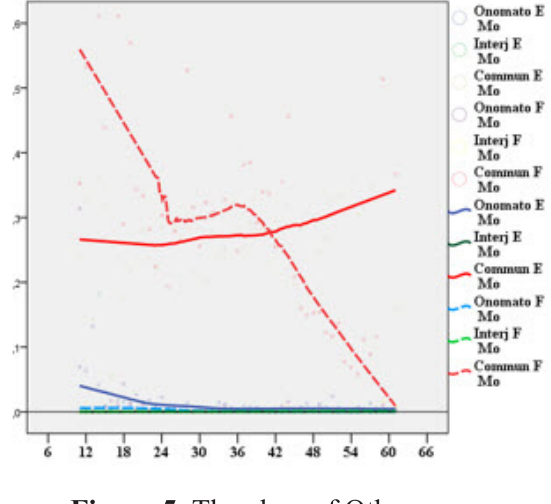
Figure 5. The class of